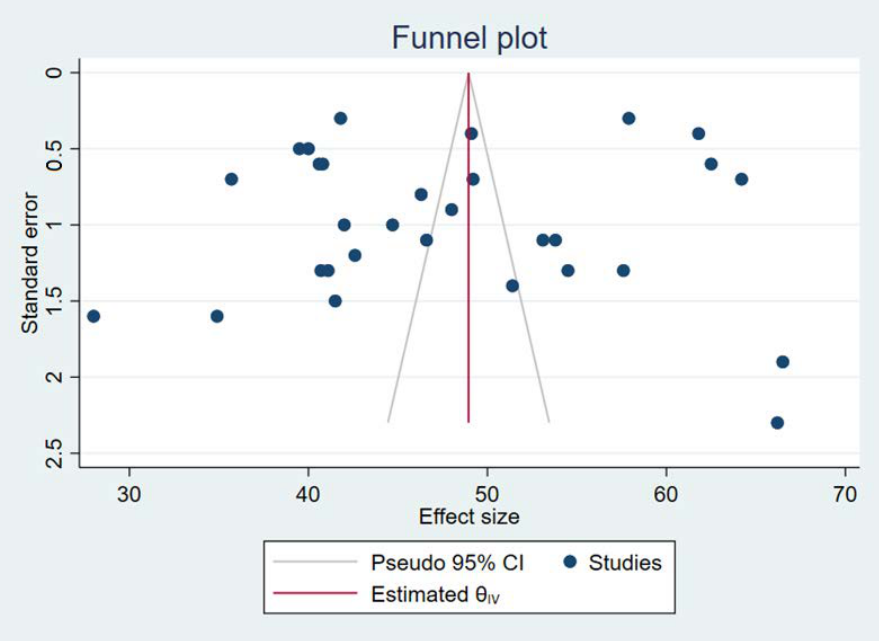
Figure 3. Funnel plot of the studies (n =